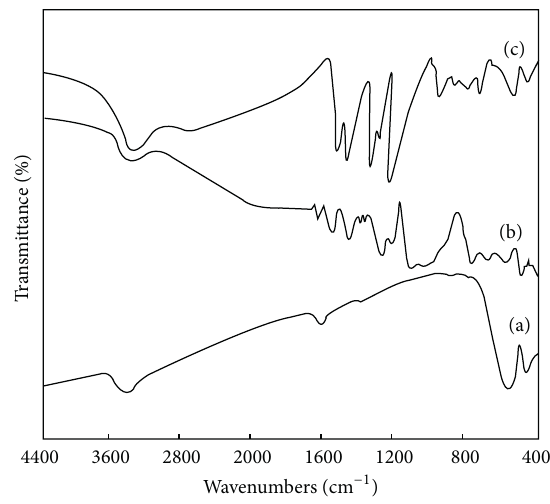
Figure 1: FTIR spectra of (a) Fe 3 O 4 ferrite nanocrystals, (b) PANI, and (c) Fe 3 O 4 ferrite/PANI nanocomposites.